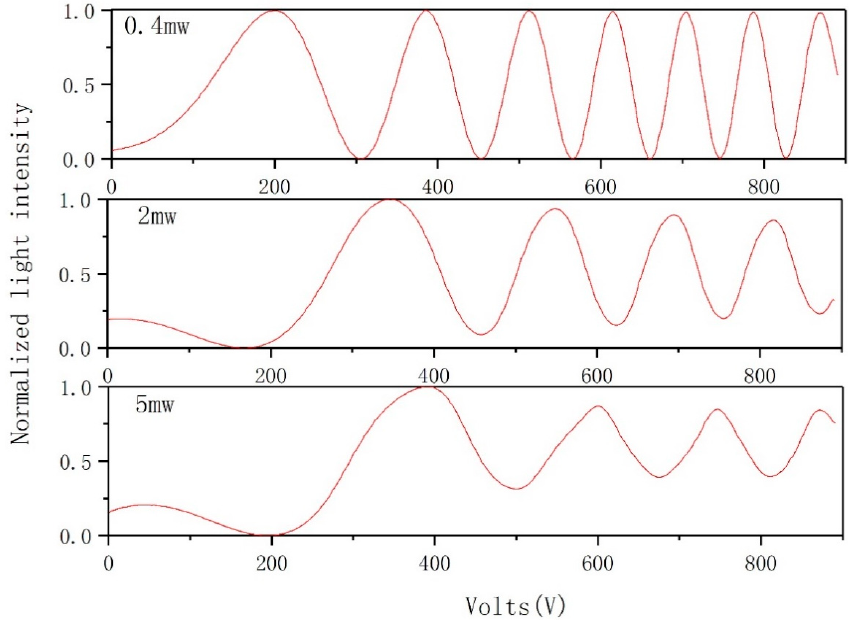
Figure 8. Modulation curve of light intensity under different powers of incident light.